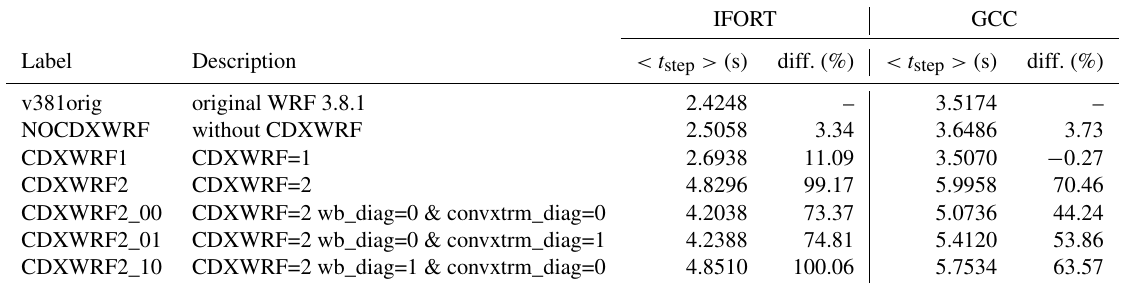
Table 4. Mean elapsed time step of 5-day simulation and difference in time with respect to the original version of the code (v381orig) for different model configurations. See text for more